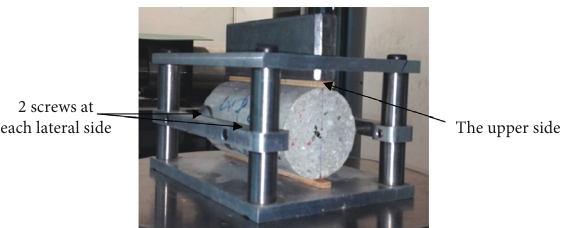
Figure 3: Apparatus used to hold the concrete specimen at the beginning of the indirect tensile